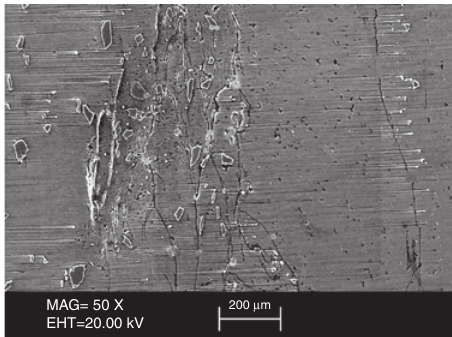
Figure 13 SEM microstructure image of the N8